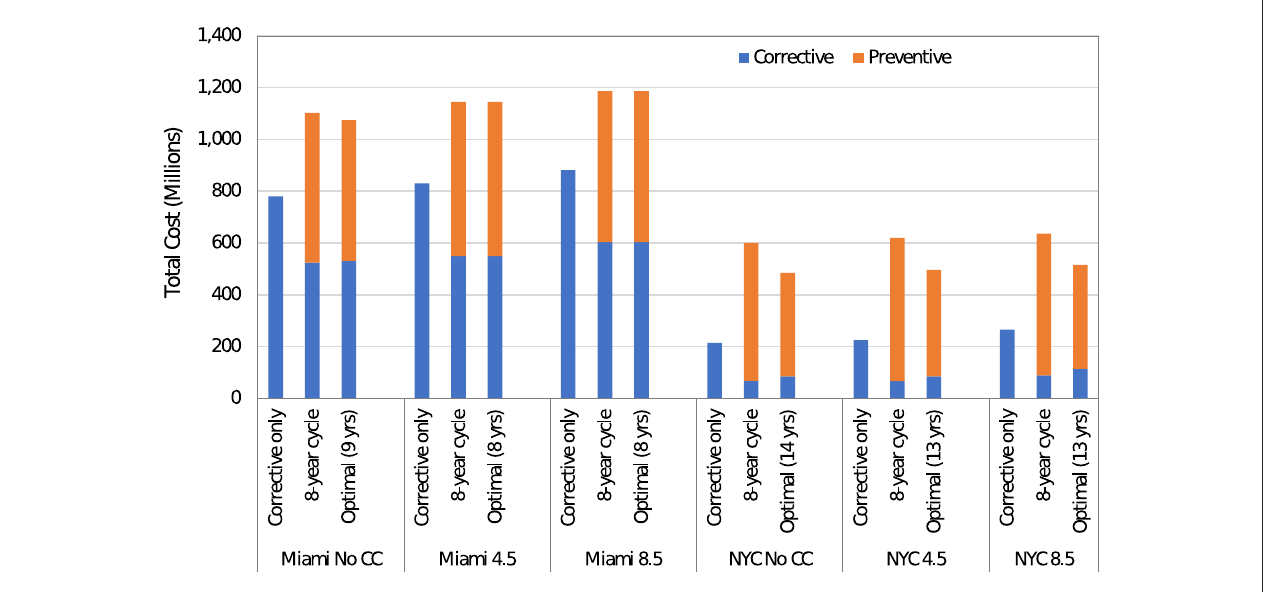
FIGURE 10 | Comparison of total replacement costs from 2010 to